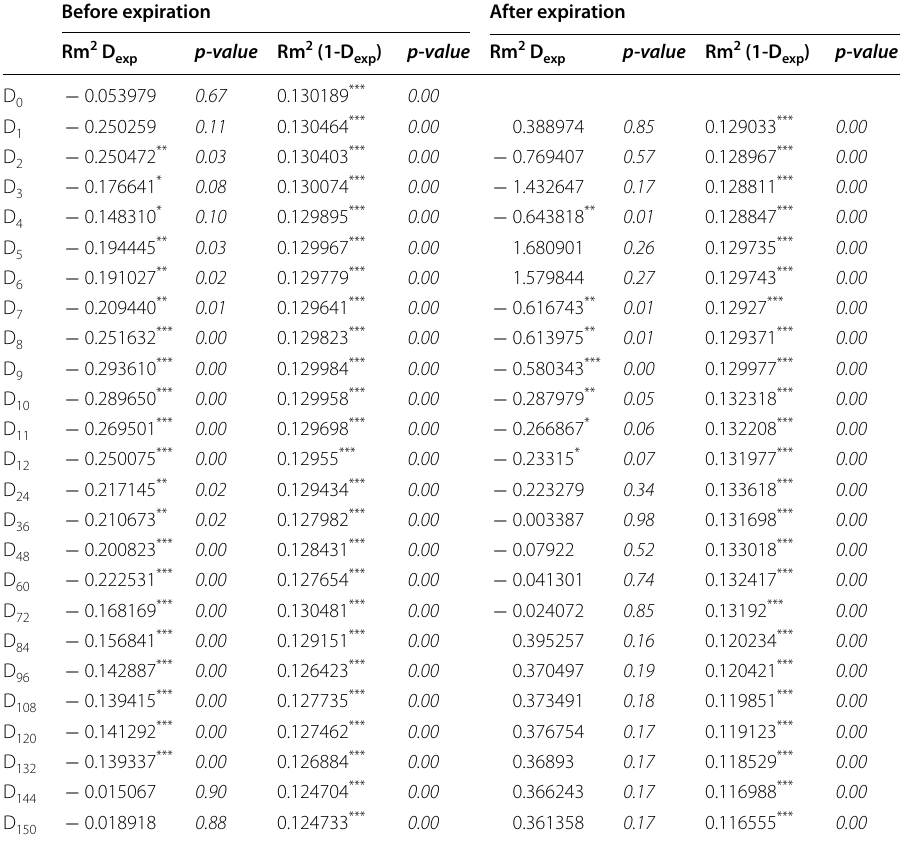
Table 5 Robustness tests OLS regressions using the US volume to compute the return of the market